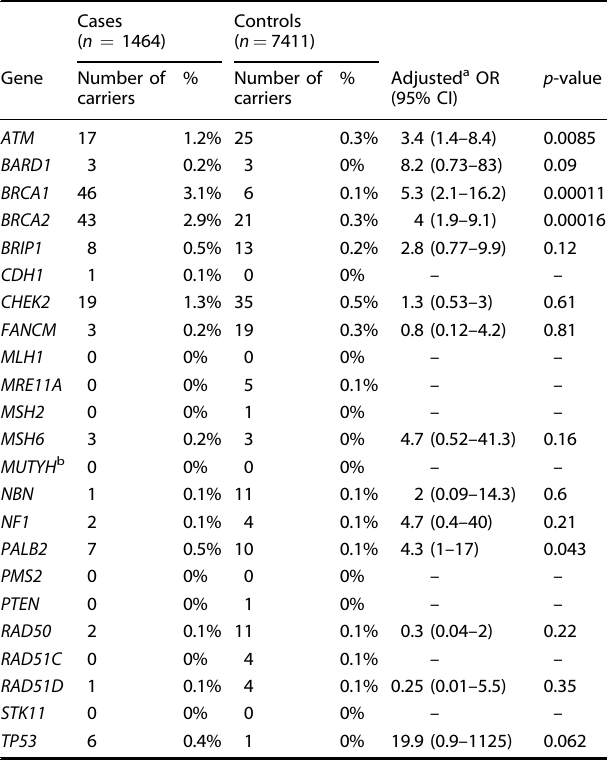
Table 2. Pathogenic variant carriers identi fi ed by gene-panel testing and the odds ratios (ORs) and corresponding 95% con fi dence intervals (CIs) for associations with breast cancer.